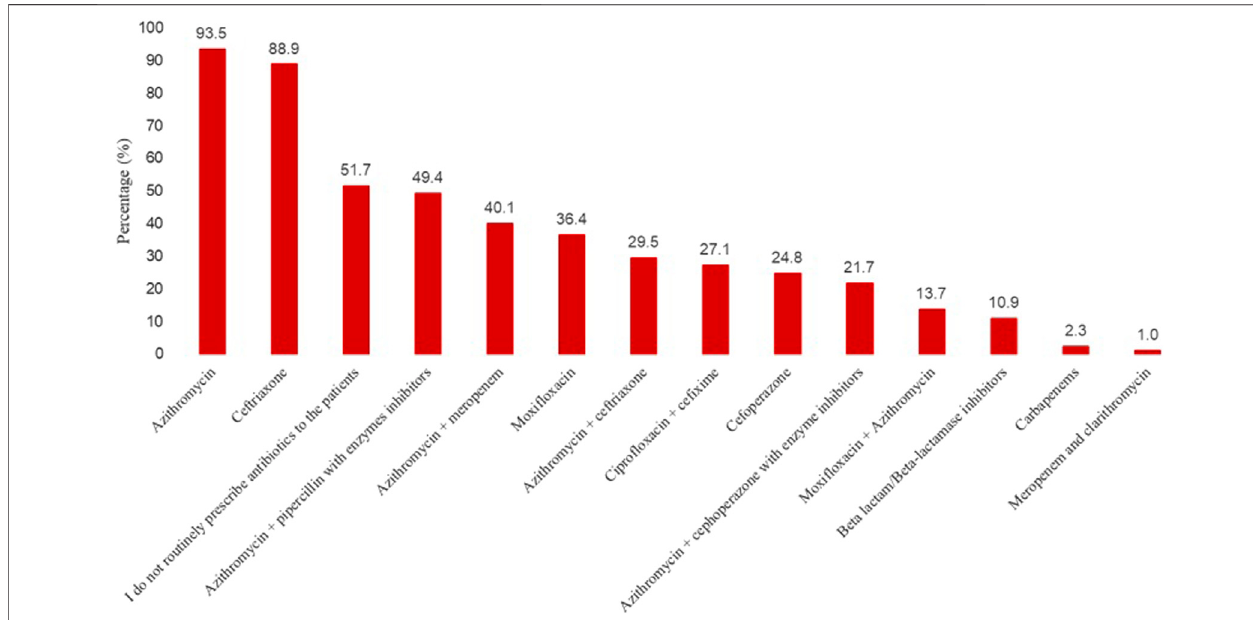
FIGURE 1 | Most usual empirical choice(s) of antibiotics in patients with COVID-19 on the ward.